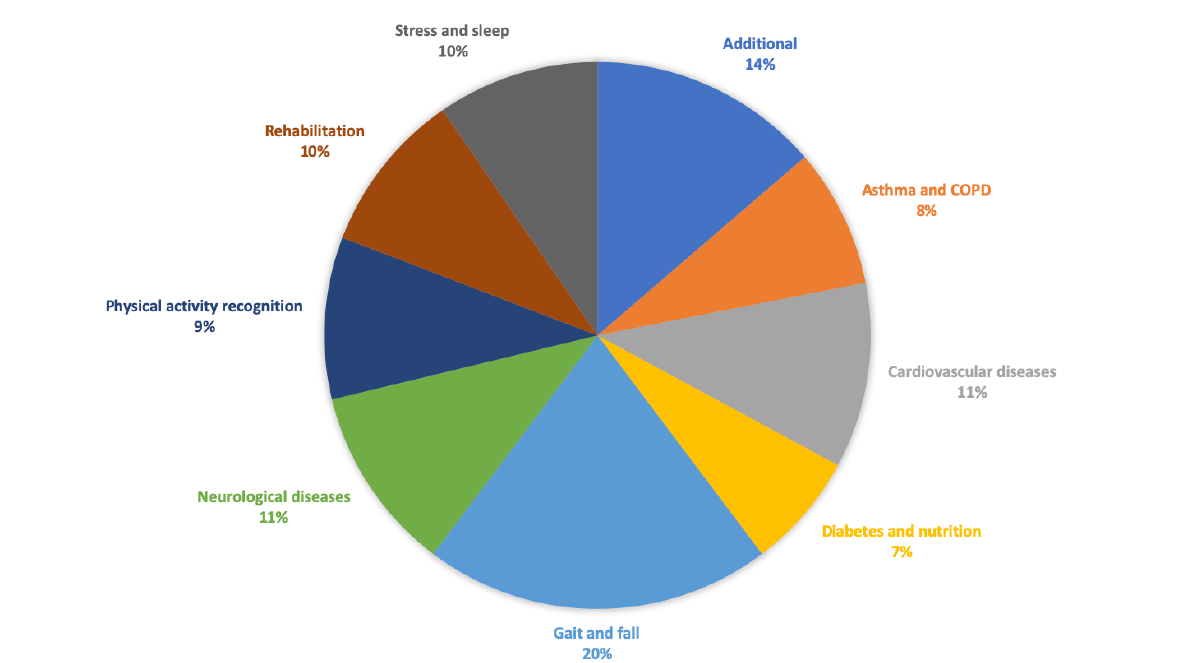
Figure 5. Category-wise distribution of the selected articles. Number of articles for Additional = 10, Asthma/COPD = 6, Cardiovascular diseases = 8, Diabetes and nutrition = 5, Gait and fall = 15, Neurological diseases = 8, Physical activity recognition = 7, Rehabilitation = 7, Stress and sleep =